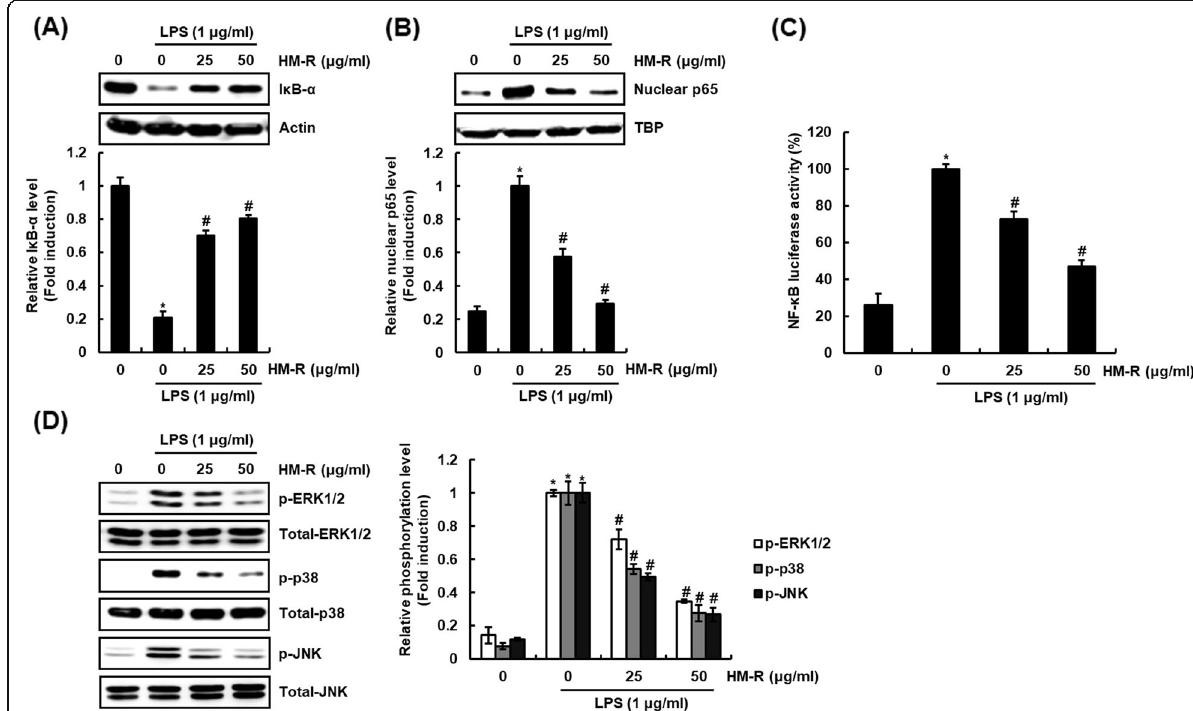
Fig. 3 Inhibitory effect of HM-R against NF- κ B and MAPK signaling activation in LPS-stimulated RAW264.7 cells. a , d RAW264.7 cells were pretreated with HM-R for 2 h and then co-treated with LPS (1 μ g/ml) for 20 min. b RAW264.7 cells were pretreated with HM-R for 2 h and then co-treated with LPS (1 μ g/ml) for 30 min. After the treatment, the nucleus fraction was prepared. For Western blot analysis, the cell lysates were subjected to SDS-PAGE and the Western blot was performed using antibodies against I κ B- α and p65. Actin was used as internal control for Western blot analysis. The density of Western blot bands was calculated using the software UN-SCAN-IT gel version 5.1 (Silk Scientific Inc. Orem, UT, USA). *P < 0.05 compared to the cells without the treatment, and # P < 0.05 compared to the cells treated with LPS alone. c RAW264.7 cells were co-transfected with NF- κ B luciferase constructs and pRL-null. The cells were pretreated with HM-R for 2 h and then co-treated with LPS (1 μ g/ml) for 18 h. Luciferase activity for NF- κ B was measured as a ratio of firefly luciferase signal/renilla luciferase signal using a dual luciferase assay kit. *P < 0.05 compared to the cells without the treatment, and # P < 0.05 compared to the cells treated with LPS